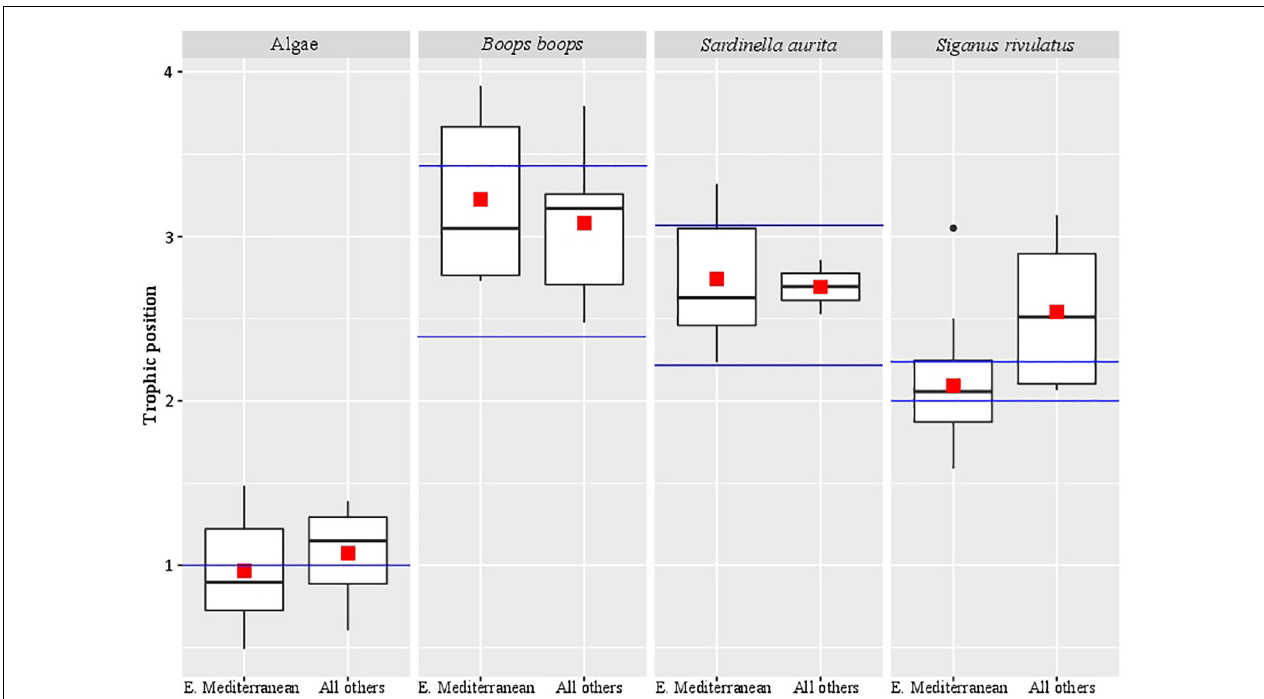
FIGURE 1 | Trophic position of samples from different locations. The red square marks the average trophic position, the black bar in the box marks the median, the black dots are outlier values and the blue bars mark the literature-based trophic position range.